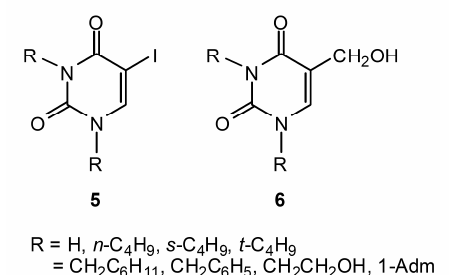
Figure 2. Title substituted uracils 5 and